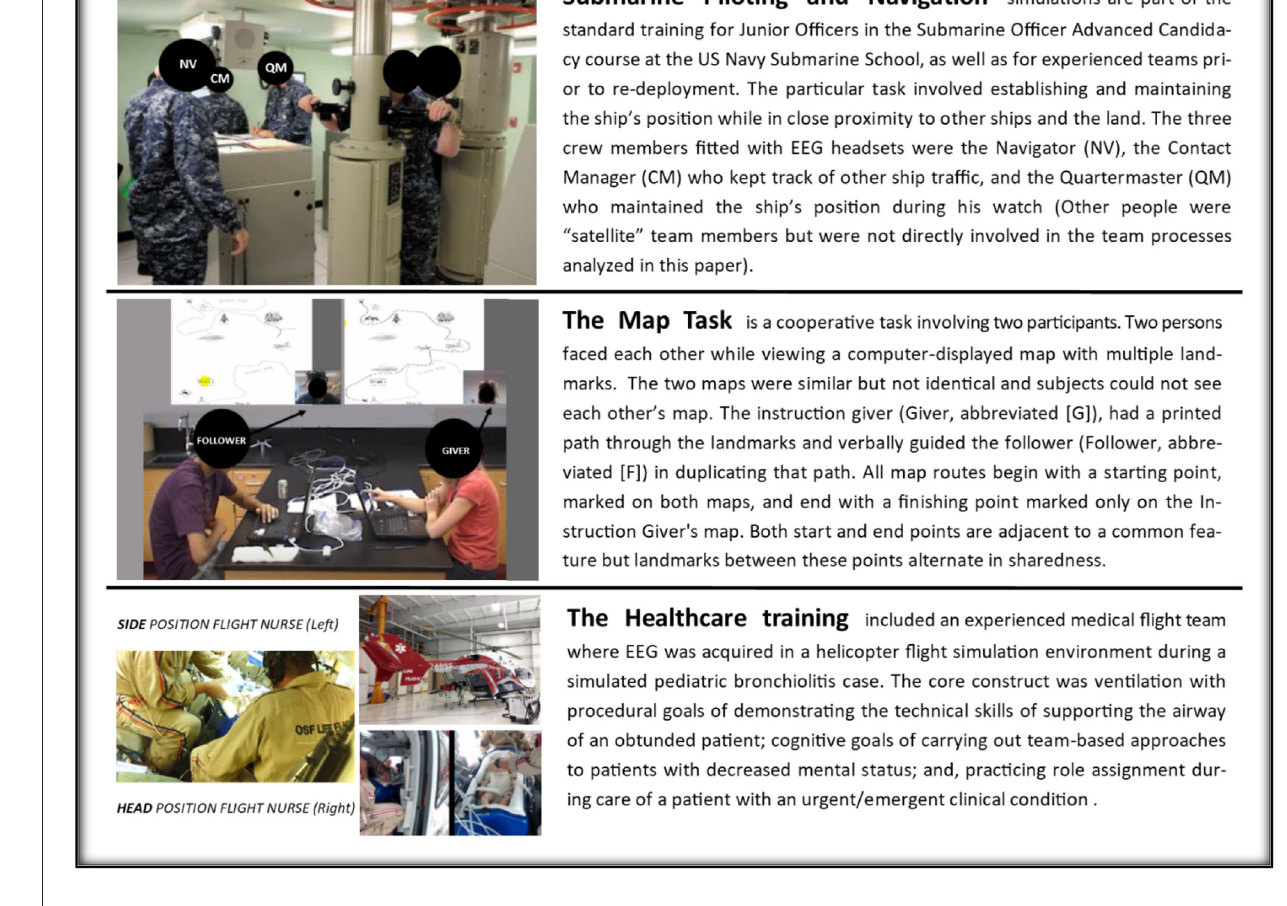
FIGURE 1 | Summaries of the tasks and brief displays of their physical